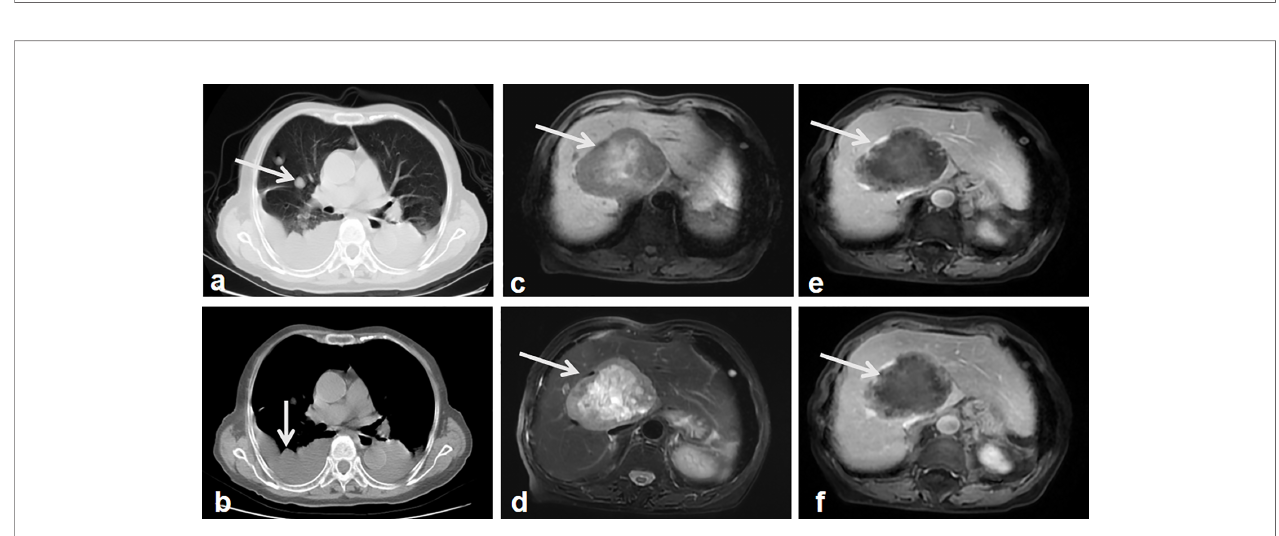
FIGURE 4 | Follow-up images after surgery. Lung CT shows multiple nodules in the lung and thoracic effusion, which indicate the lung and possible pleural metastasis ( A, B , arrow). MR T1 weighted images show a well-demarcated, heterogeneous hypointense signal tumor in the right lobe of the liver with patchy hypersignal intensities in the central of the tumor ( C , arrow). MR weighted images show the tumor mass with heterogeneous hypersignal intensities ( D , arrow). Contrast-enhanced MR weighted images of arterial (E) , portal phase (F) show the tumor mass with intermediate enhancement of the peripheral component, the non- enhanced hypointense signal central area